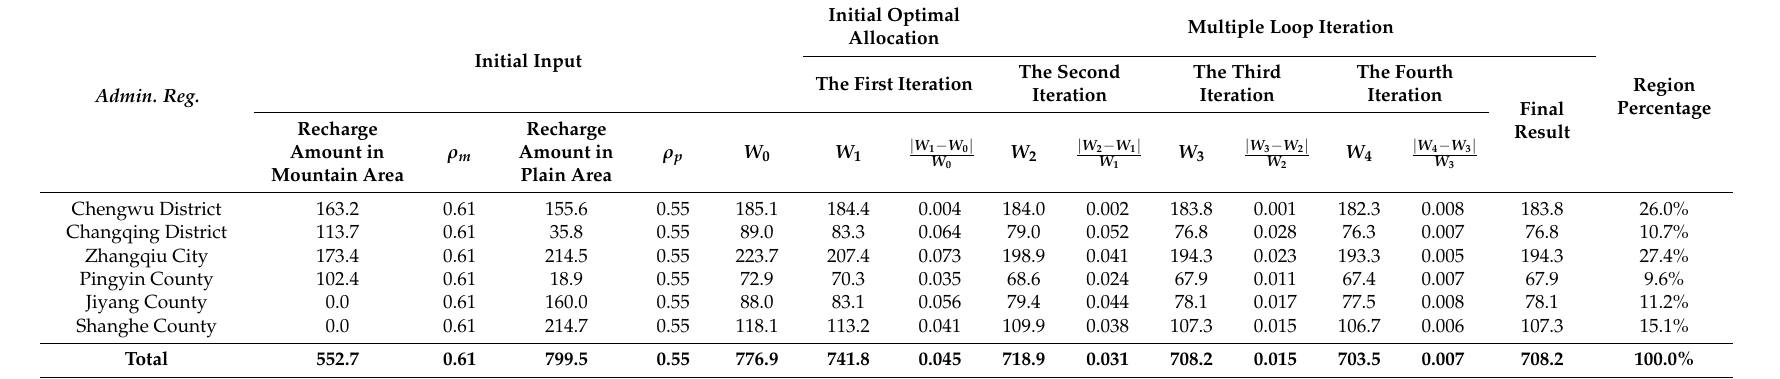
Table 4. Iterative calculation of exploitable groundwater (units for W j : million m 3 ). Admin. Reg. : Administration Region.